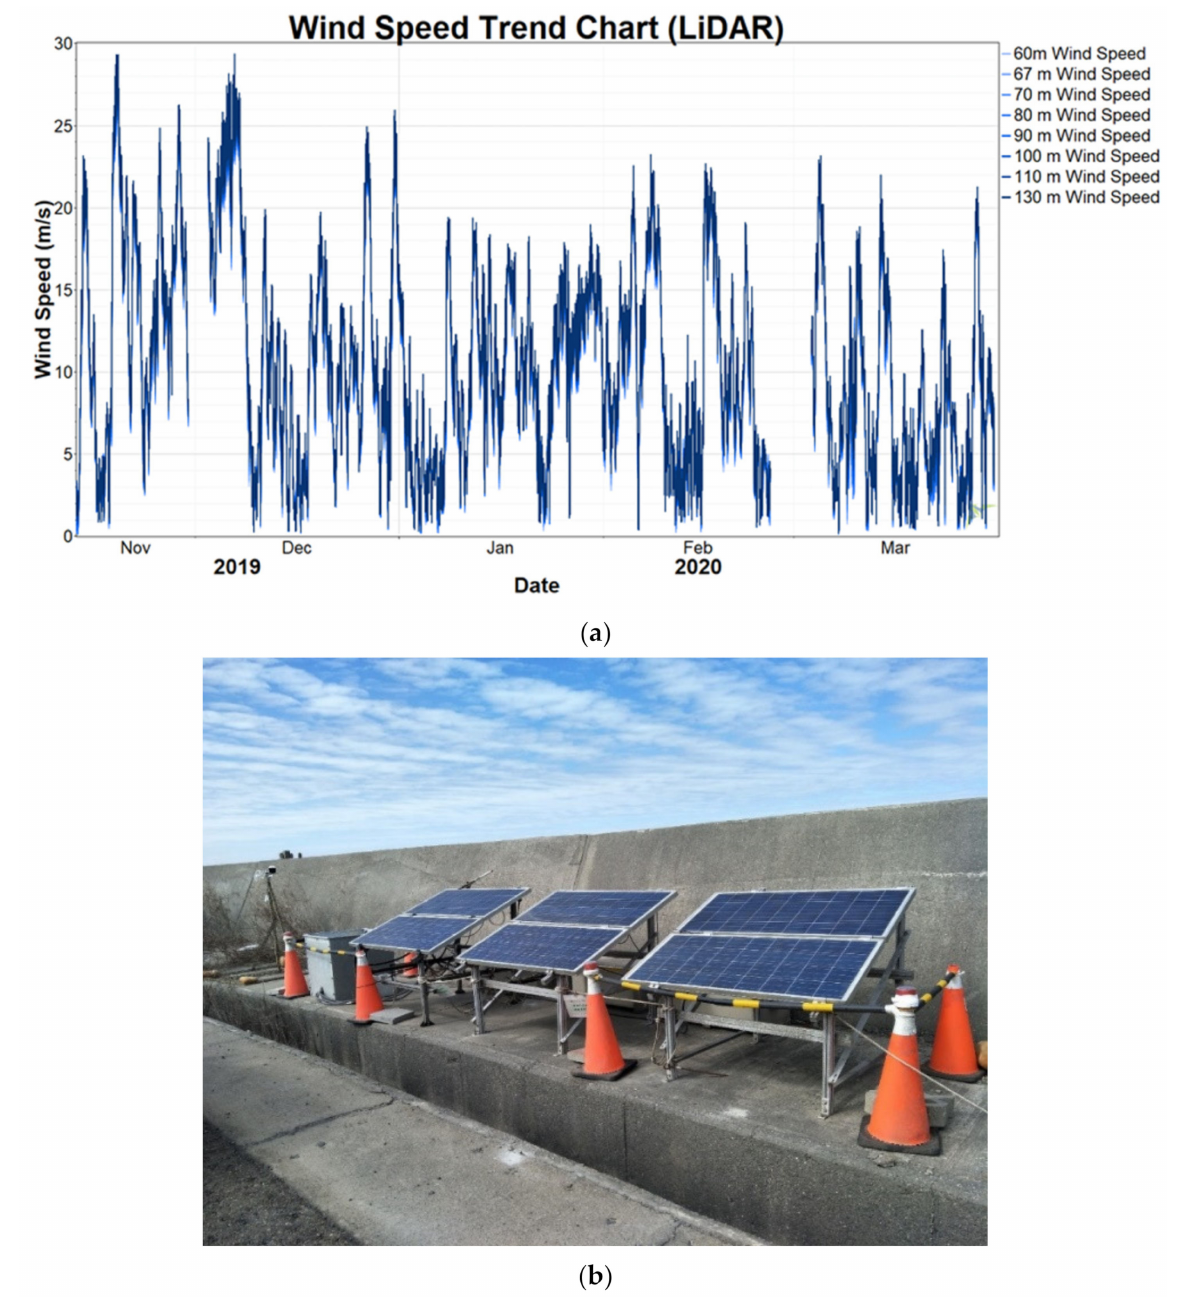
Figure 4. ( a ) Wind speed measured by LiDAR; ( b ) measuring LiDAR in Changhua Coastal Industrial Park. Figure 5 depicts the nearshore wind direction, which keeps to the northeast for most winters in Taiwan. The dominant wind direction is about 22.5 degrees due to the monsoon in Taiwan. Although wind direction is not steady all the time, it correlates with wind speed. Higher wind speed can sustain wind-direction stability, as the main air flow dominates the wind direction with higher dynamic energy than subordinate flows